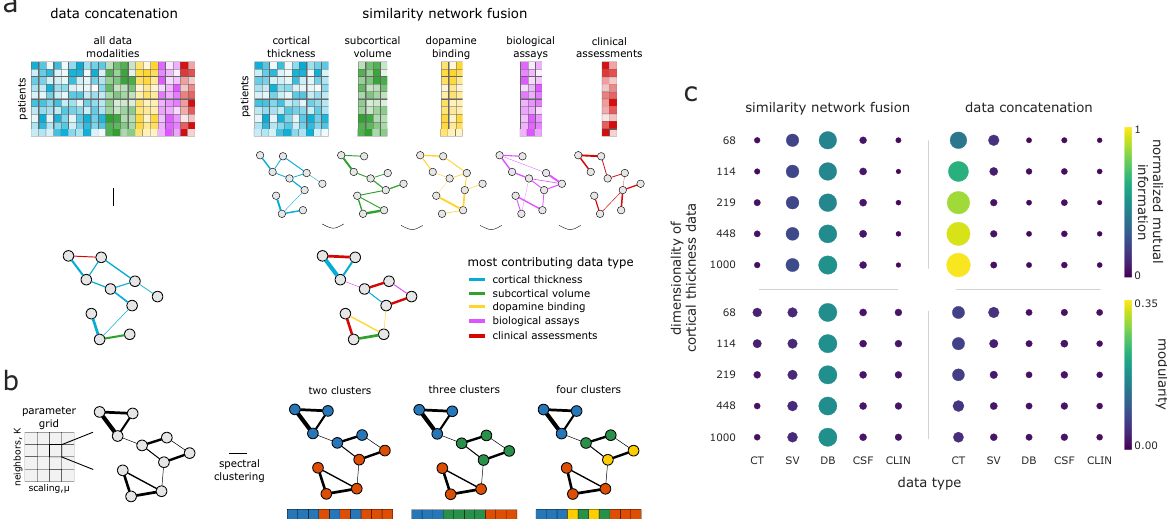
Fig. 2 Comparison of data concatenation and SNF for integrating data. a Toy diagram depicting generation of a patient similarity network from data concatenation in contrast to SNF. The highest dimensionality data — in this case, cortical thickness — tends to be over-represented in the similarity patterns of the patient network generated with data concatenation, whereas SNF yields a more balanced representation. b An exhaustive parameter search was performed for 10,000 combinations of SNF ’ s two hyperparameters ( K and μ ). We subjected the resulting fused patient network for each combination to spectral clustering for a two-, three-, and four-cluster solution. Clustering solutions were combined via a “ consensus ” clustering approach (see “ Methods: Consensus clustering ” , Fig. 1c) 30,31 . c The impact of cortical thickness feature dimensionality on normalized mutual information (NMI) and modularity for different data modalities in data concatenation compared to SNF. NMI estimates are computed by comparing the clustering solutions generated from the concatenated/SNF-derived patient network with the solutions from each single-modality patient network. Modularity estimates are computed by applying the clustering solutions from the concatenated/SNF-derived patient network to the single-modality patient network. CT = cortical thickness; SV = subcortical volume; DB = DAT binding; CSF = CSF assays; CLIN = clinical-behavioral